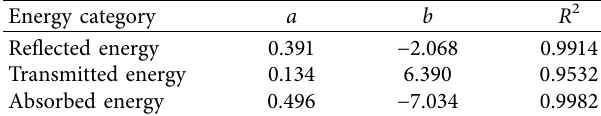
Figure 12: Curve of reflected energy, transmitted energy, and absorbed energy with incident energy. Table 1: Fitting parameters of dissipation energy.